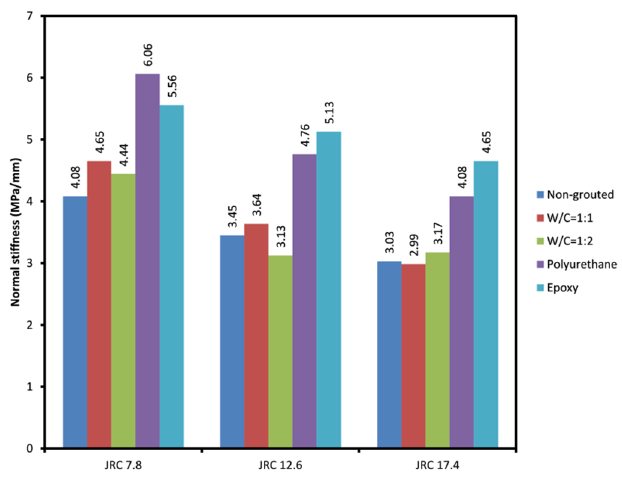
Figure 5. Average normal stiffness obtained for the rock joints tested .